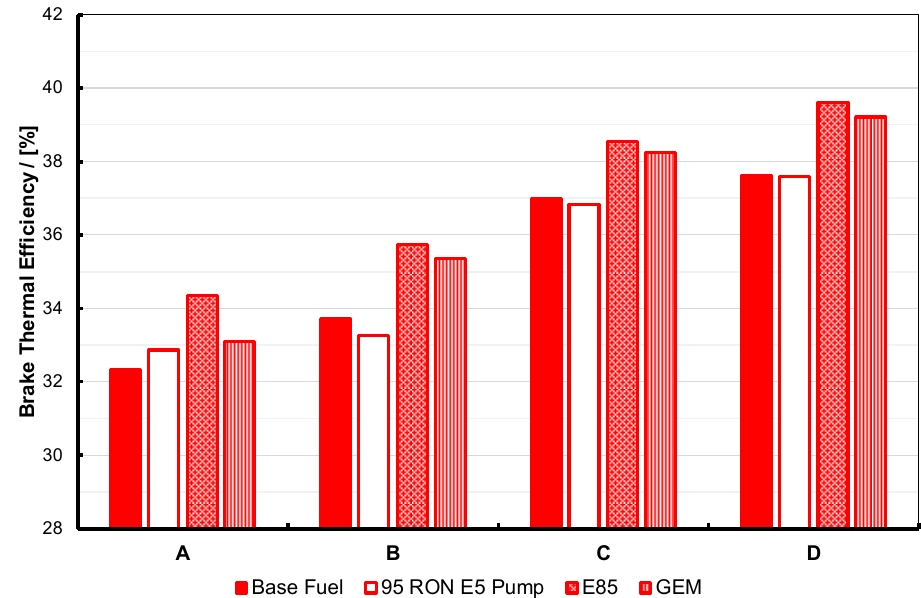
Figure 10. Brake thermal efficiency at maximum torque for the base and 95 RON pump gasolines, E85 and the GEM blend, at four different fixed-intake conditions, operated at KLSA ignition timing. For description of the test operating points, labelled A to D here, see Table 3 and text. Note that the two high-alcohol blends have nearly-matched stoichiometry and enthalpy of vaporization, RON and MON, and as a consequence perform in an essentially identical manner.